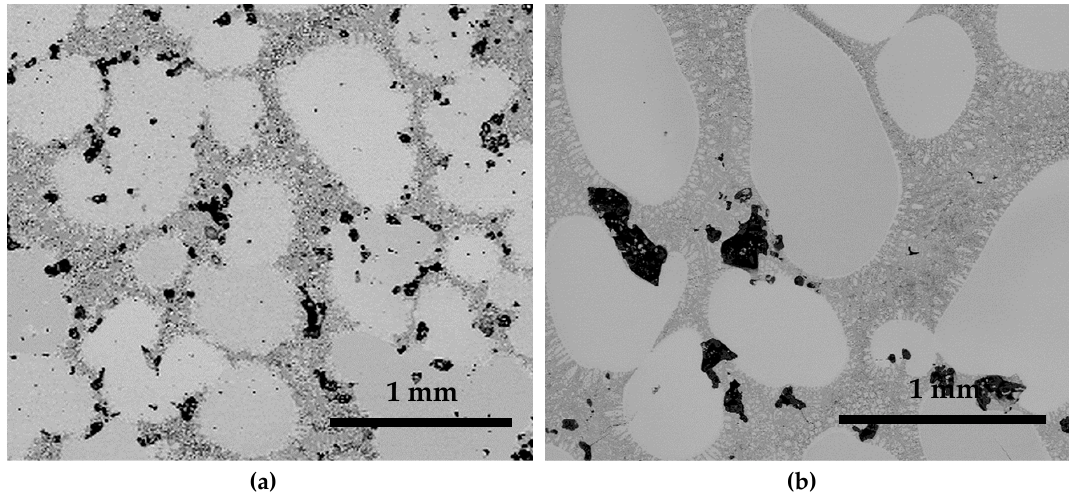
Figure 5. BSE images of samples: ( a ) S1050a3 and ( b ) S1050b4.